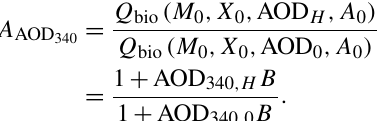
Fig. 4. Highly variable AOD 340 values at different